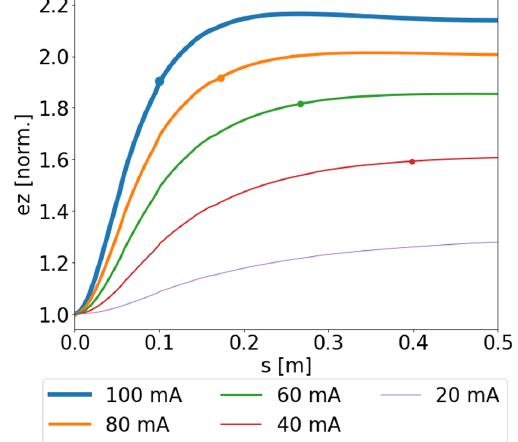
7. rms emittance evolution for initially Gaussian beam